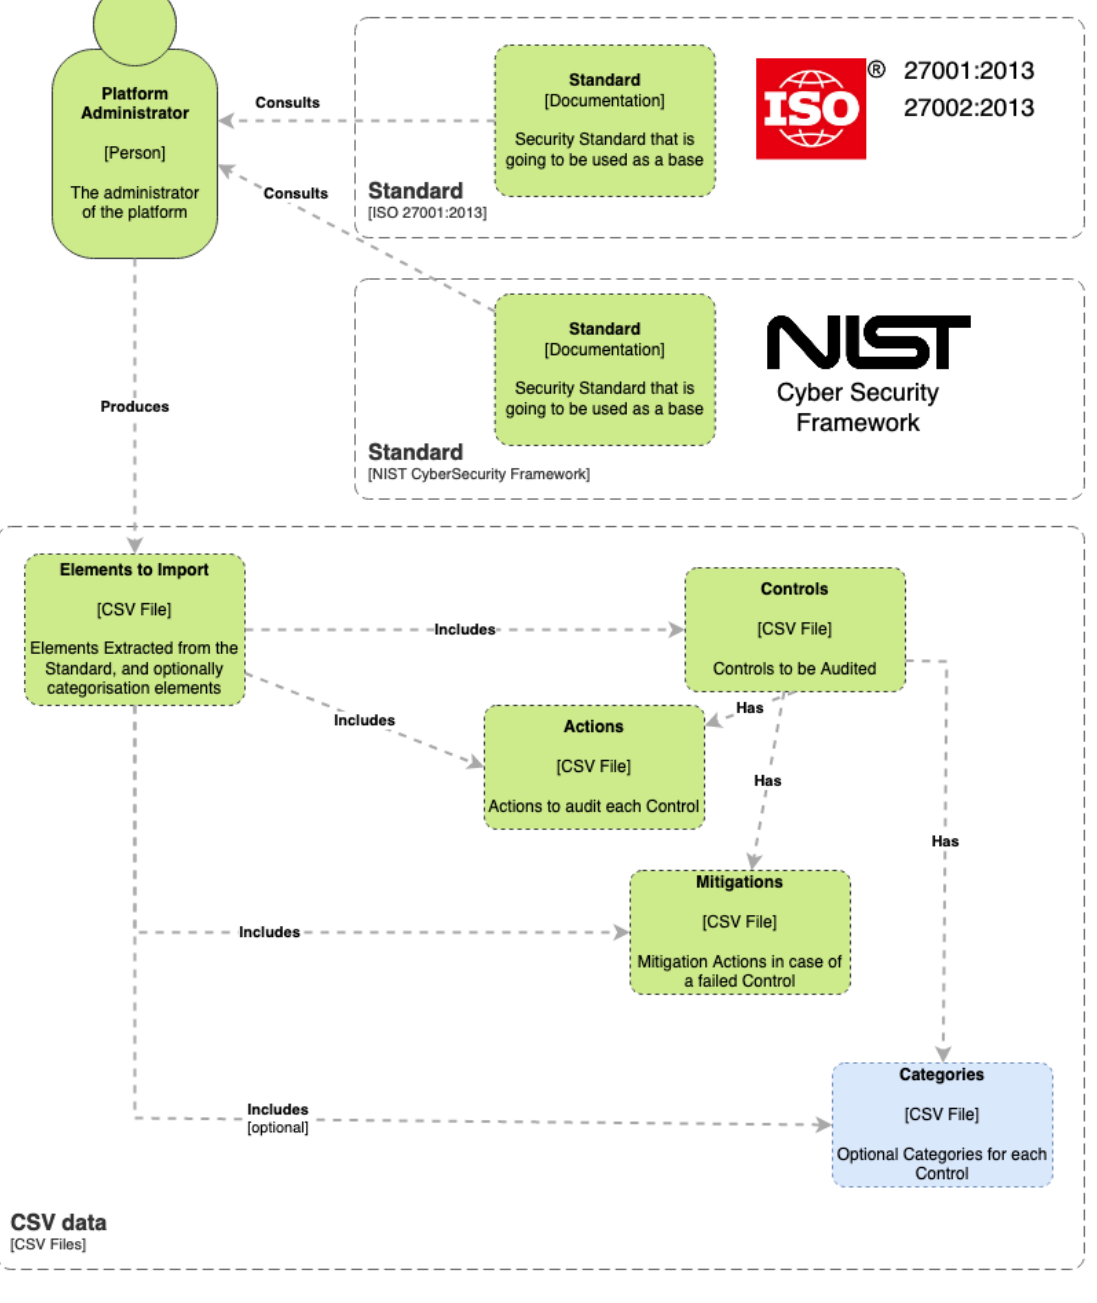
Figure 3. The C4 Level 2 diagram: customization from multiple